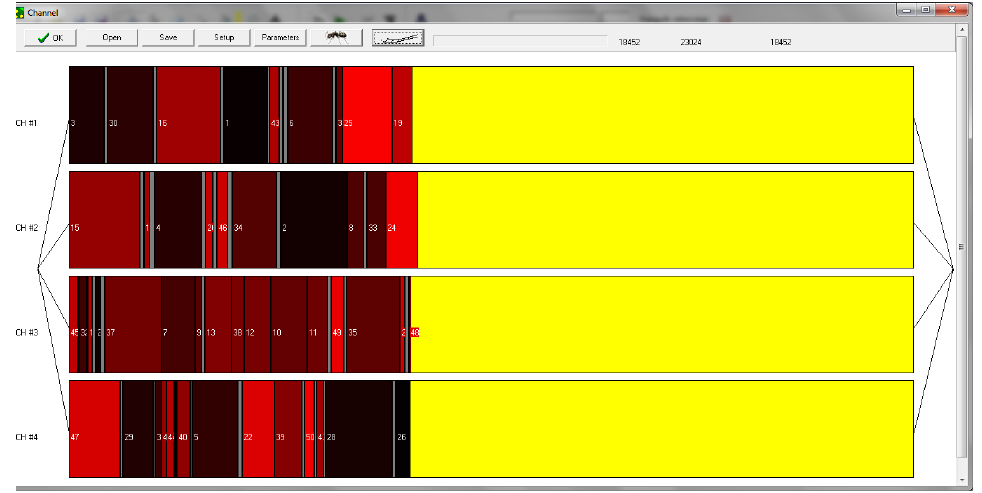
Figure 3. The optimization panel with the parameters.